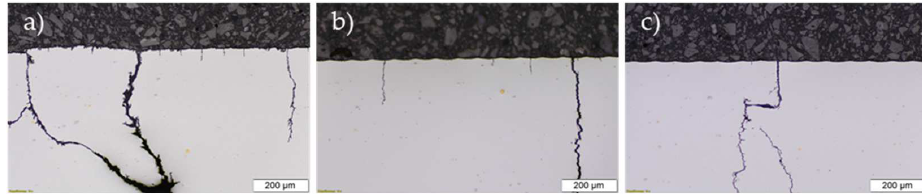
Figure 9. Optical microscope images of the fatigued specimens in the region of crack initiation: ( a ) 0.3%, ( b ) 0.5%, and ( c ) 0.7% strain amplitude .